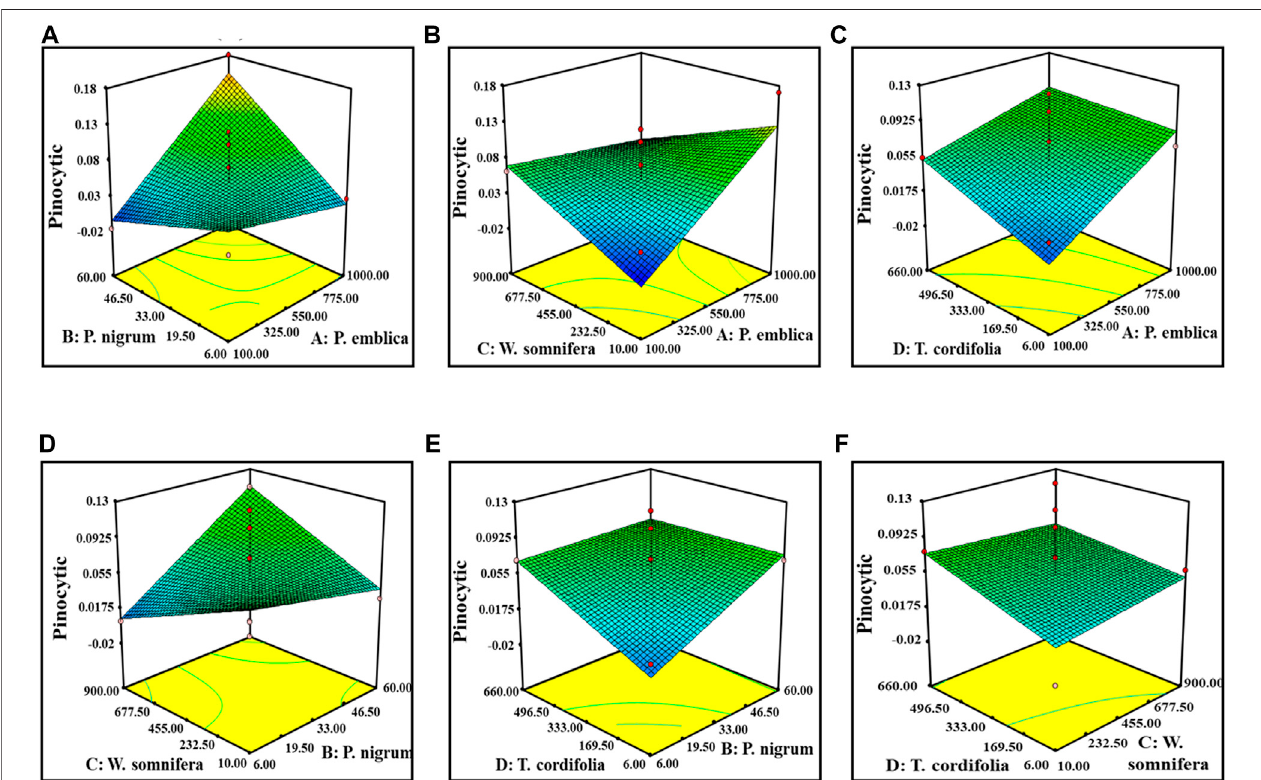
FIGURE 3 | Response surface graph showing the interaction among four extract concentrations and pinocytic activity. Interaction between (A) P. emblica and P. nigrum , (B) P. emblica and W. somnifera , (C) P. emblica and T. cordifolia , (D) P. nigrum and W. somnifera , (E) P. nigrum and T. cordifolia , and (F) W. somnifera and T. cordifolia